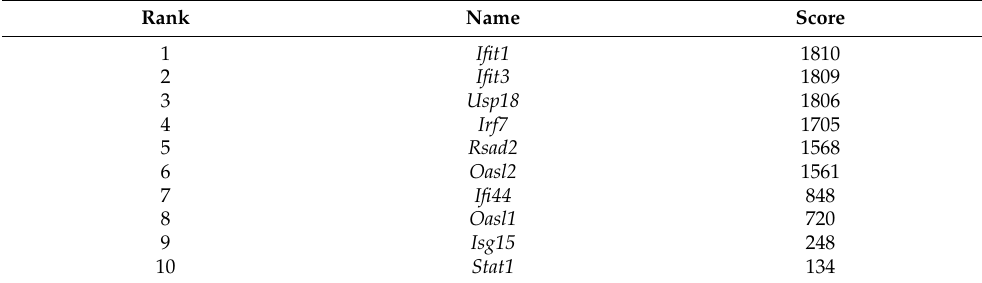
Table 2. Rank of hub genes (top